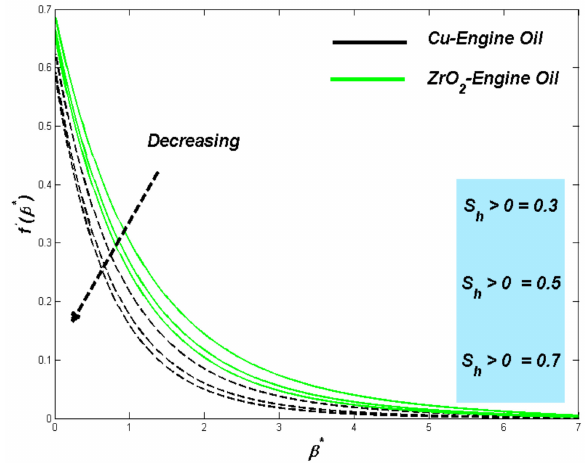
Figure 2. Velocity profile change with S h > 0.